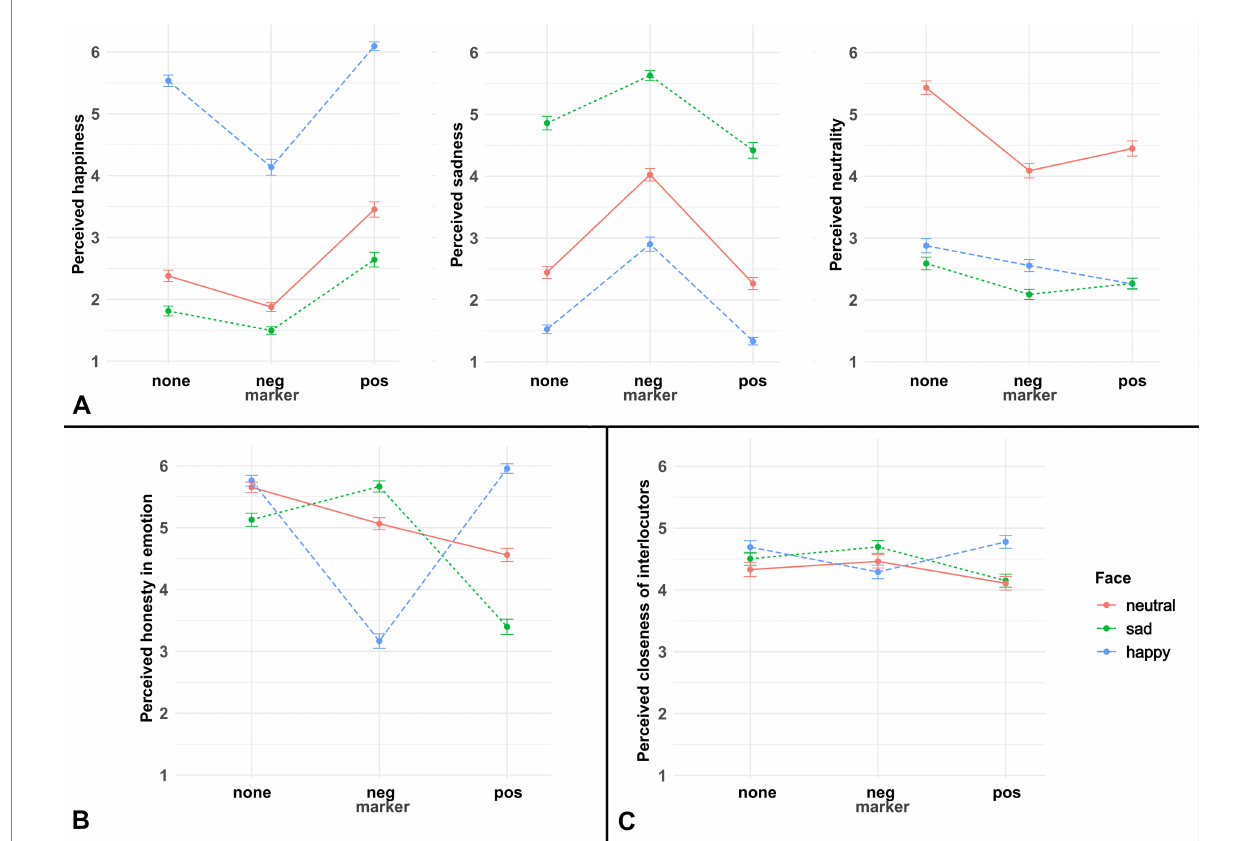
FIGURE 2 Mean ratings for all questions in Experiment 1, with error bars showing standard errors around the mean. Panel (A) of this figure shows responses on the emotion perception questions, panel (B) on the speaker perception question, and panel (C) on the interlocutor relation